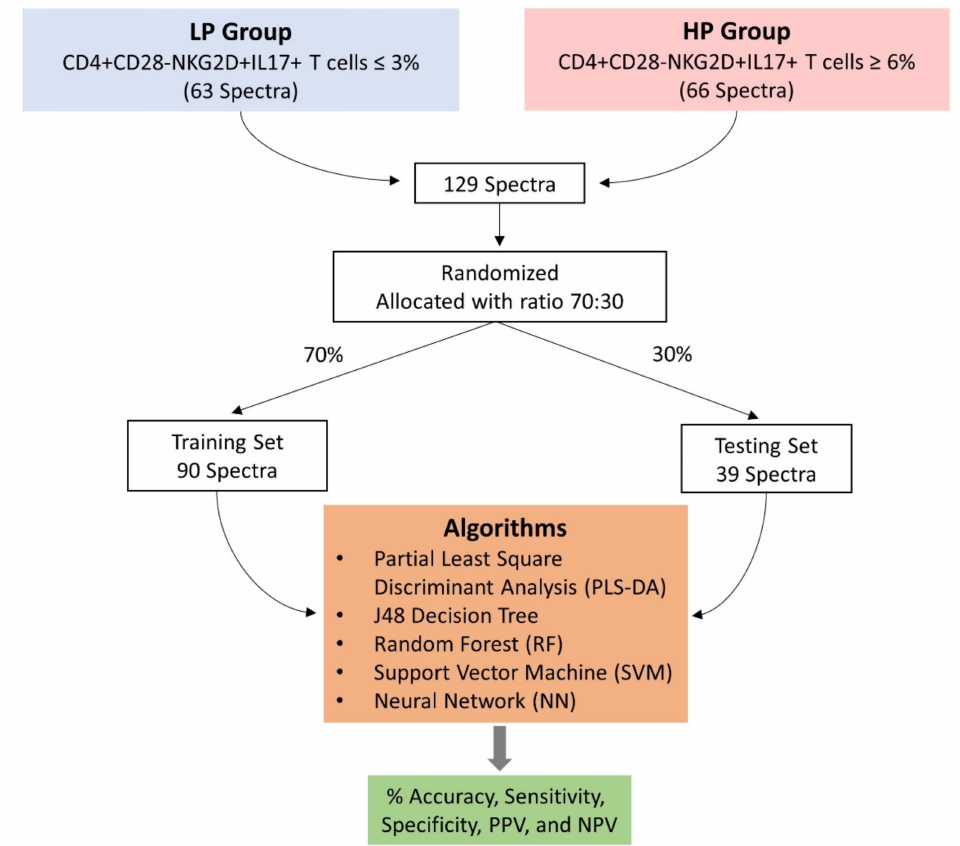
Figure 1. Workflow of the development of classification models and their performance tests. All spectra collected from two groups of samples were allocated with a ratio of 70:30 into two datasets for training and testing. The training set was used for creating classification models and the performance of the classification models was tested with a testing